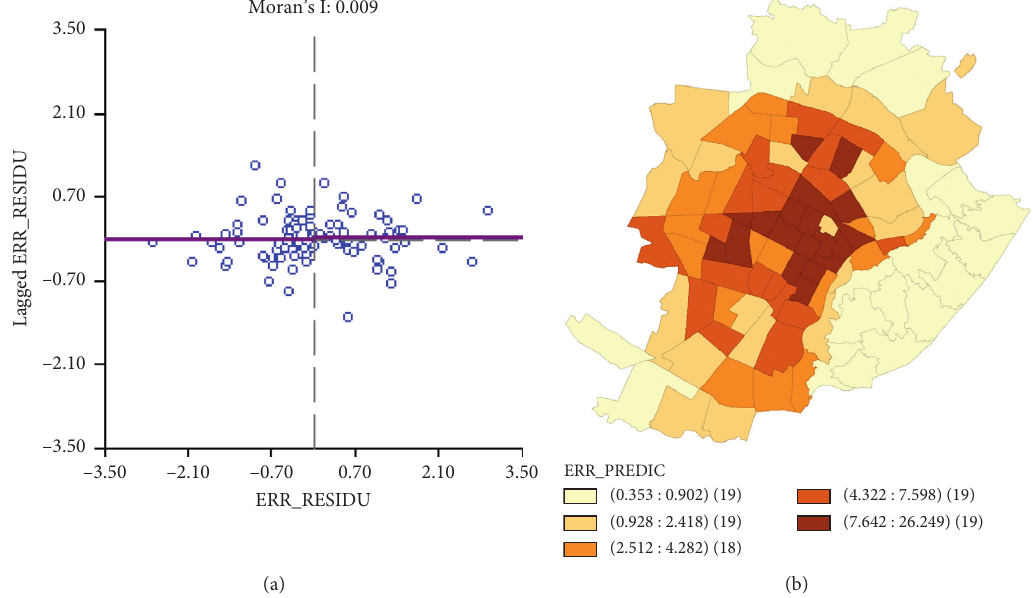
Figure 12: SER model residuals scatterplot (a) and predicted value Lisa clustering (b) (source: authors’